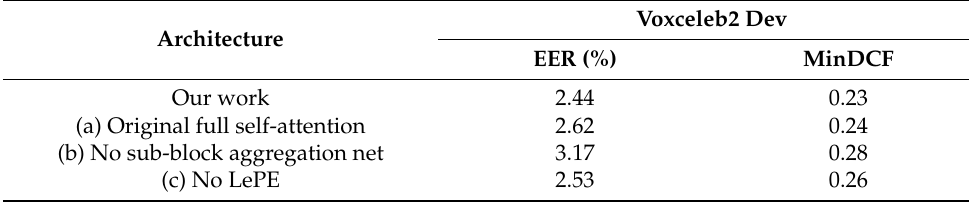
Table 3. Ablation study of our proposed